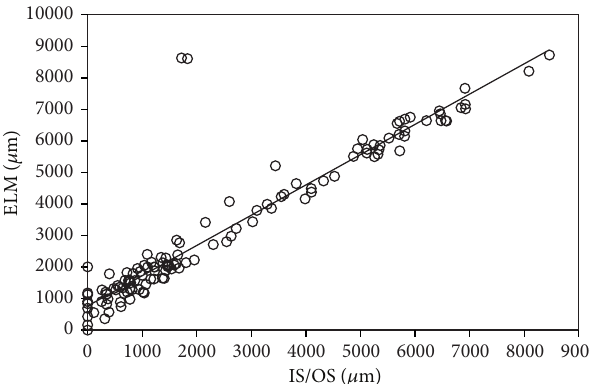
Figure 4: Correlation between the length of the external limiting membrane (ELM) line and the mean retinal sensitivity in 133 eyes with retinitis pigmentosa. There is a significant positive correlation between the length of the ELM line and the retinal sensitivity ( 𝑟 = 0.868 , 𝑃 < 0.0001 ). The solid line represents the linear regression curve (𝑦 = 0.488 + 0.002𝑥)